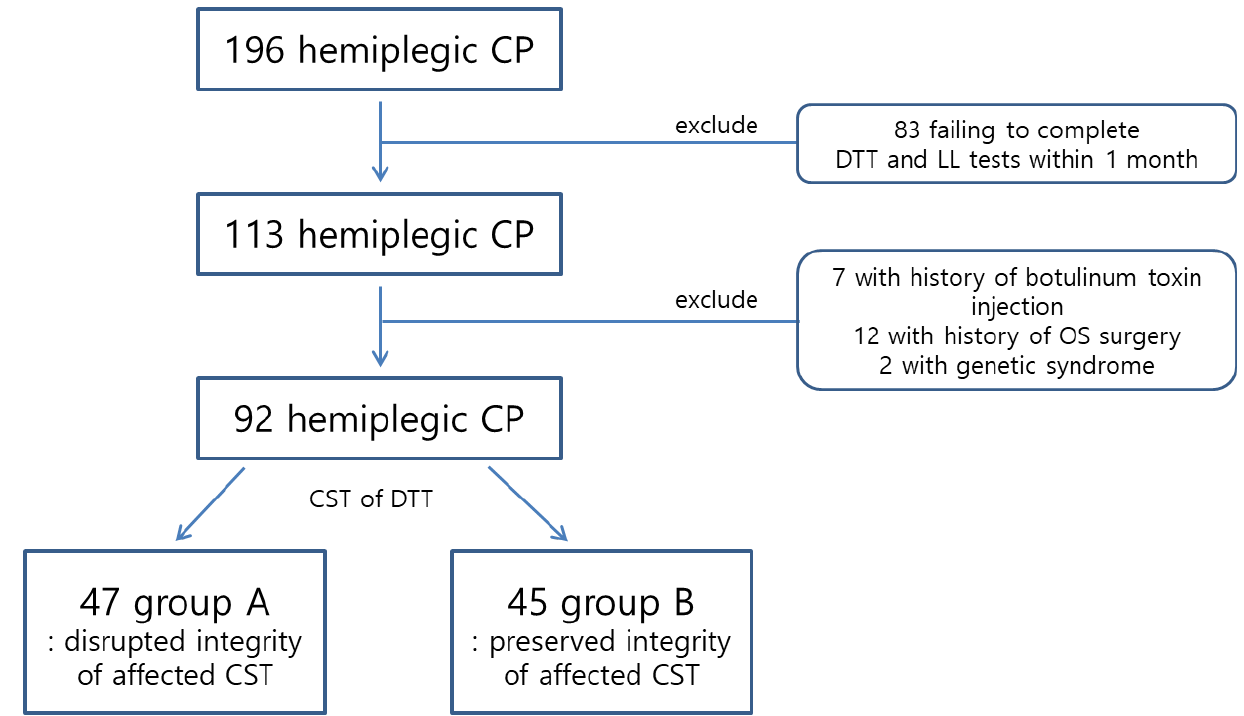
Figure 1. Flow chart of study design. (CP, cerebral palsy; CST, corticospinal tract; DTT, diffusion tensor tractography; LL, limb length evaluation; OS, orthopedic surgery).